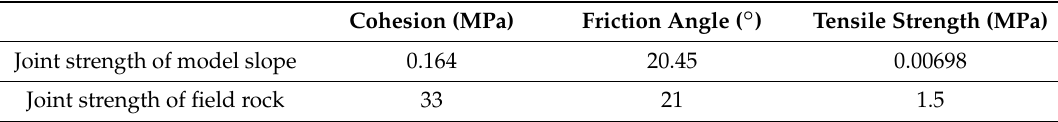
Table 6. Mechanical properties of rock joint strength (model scale).